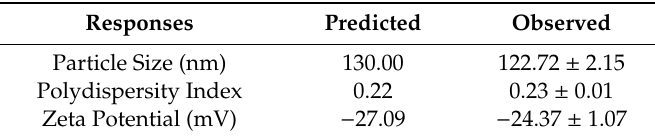
Table 4. The predicted and observed response value for the optimized SLNs. The observed data represent mean ± S.D. ( n =